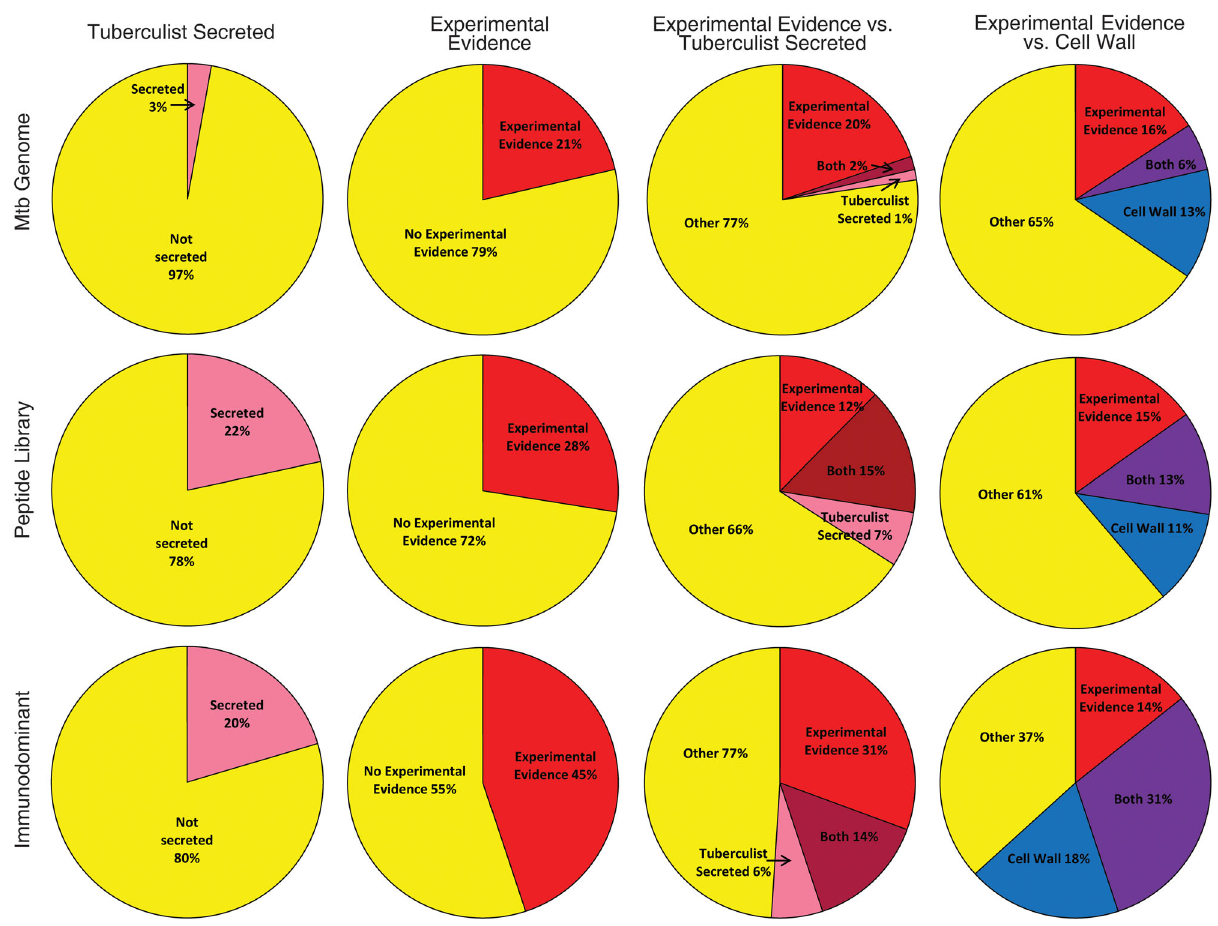
Fig. 3 Classi fi cation of secreted proteins within the Mtb genome, peptide library and immunodominant peptide pools. For the Mtb proteome, peptide library, and set of immunodominant peptide pools, the proportions of proteins categorized as secreted as de fi ned in Tuberculist in 2005, as secreted by an experimental evidence de fi nition, and/or as cell wall by Tuberculist functional classi fi cation, are shown. Using hypergeometric distribution, the probability of observing ≥ 22 peptide pools representing proteins with experimental evidence of secretion out of 49 immunodominant peptide pools by chance when the prevalence of peptide pools representing proteins with experimental evidence of secretion in the library is 28%, is 0.0053%. The probability of ≥ 15 peptide pools representing cell wall proteins with experimental evidence of secretion out of 49 by chance when the prevalence in the library is 13% is